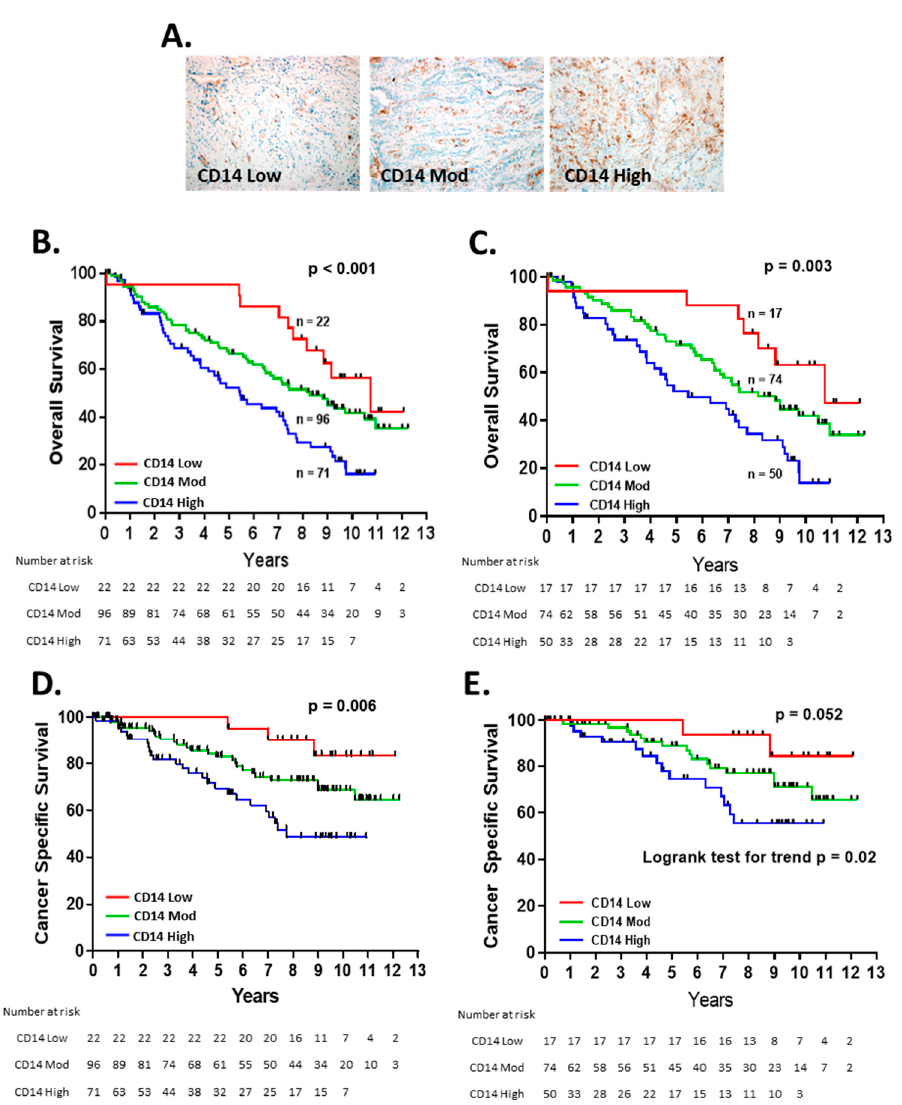
Figure 1. CD14 + cell infiltration in the NSCLC TME predicts overall survival: ( A ) representative images of CD14 low, moderate, and high. Kaplan–Meier curves of overall survival in all patients (n = 189) ( B ) and stage I and IIA patients (n = 141) ( C ) and cancer-specific survival for all patients ( D ) stage I and IIA patients ( E ). Patients were censored at date of last follow-up or non-lung-cancer- related death.